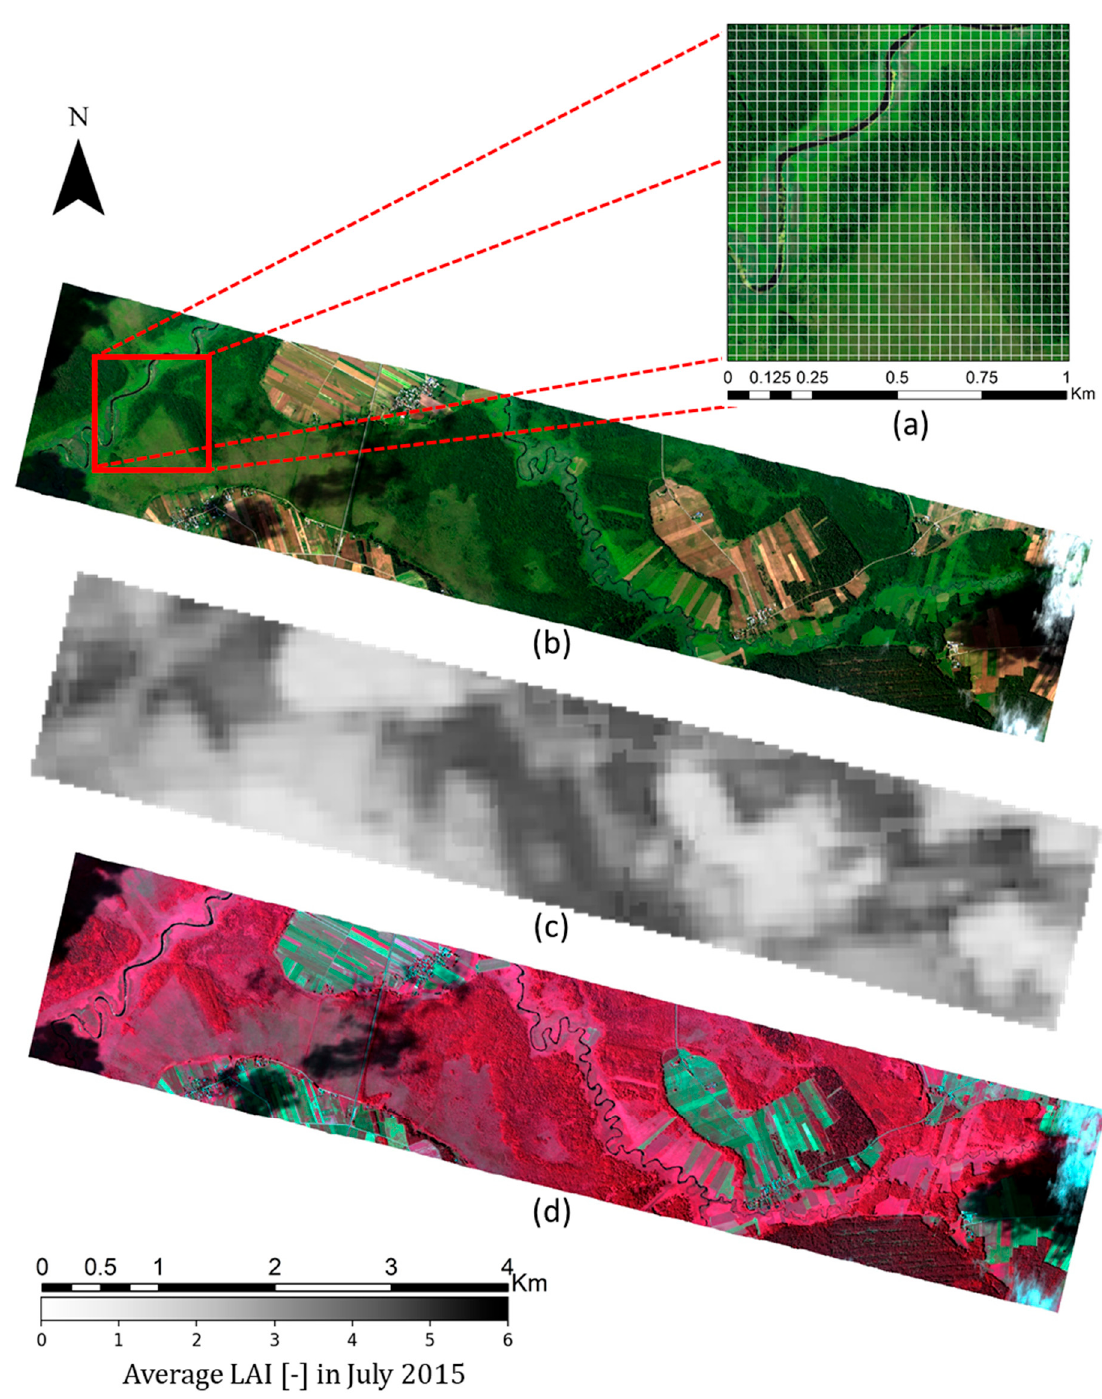
Figure 4. A comparison between true ( b ) and false ( d ) color map derived from the APEX image (2 m spatial resolution obtained on 16 July 2015) and a LAI ( c ) map (30 m spatial resolution computed based on average LAI for July 2015) processed with TREX. Top right map ( a ) is a zoomed area of 1 × 1 km with overlapped 30 m resolution grid.